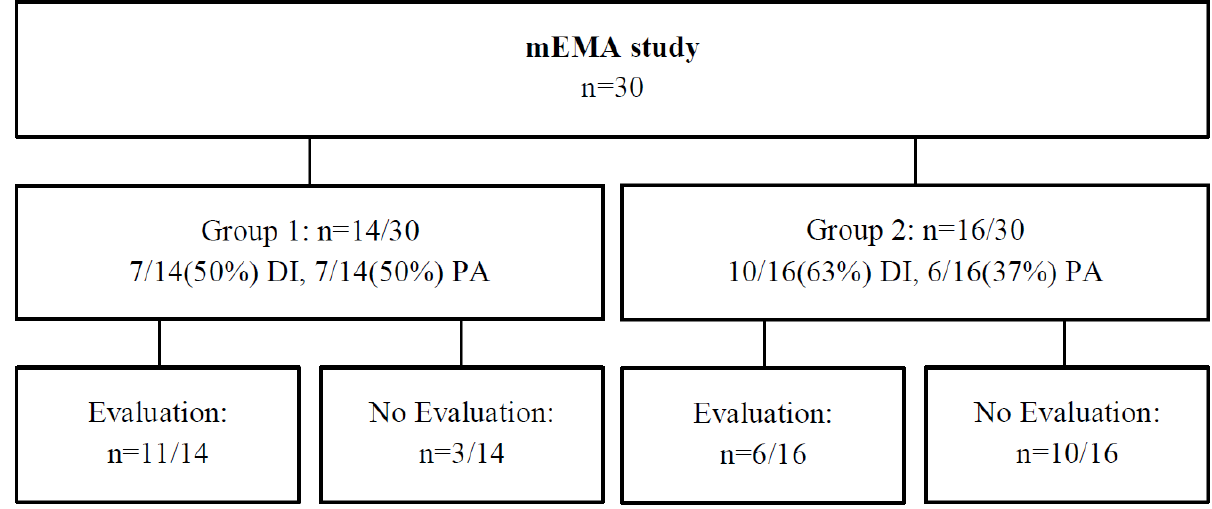
Figure 1. Study design and participant